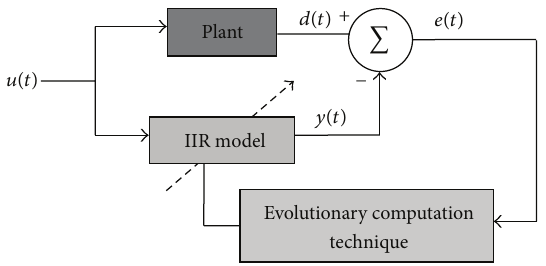
Figure 1: Adaptive IIR model for system